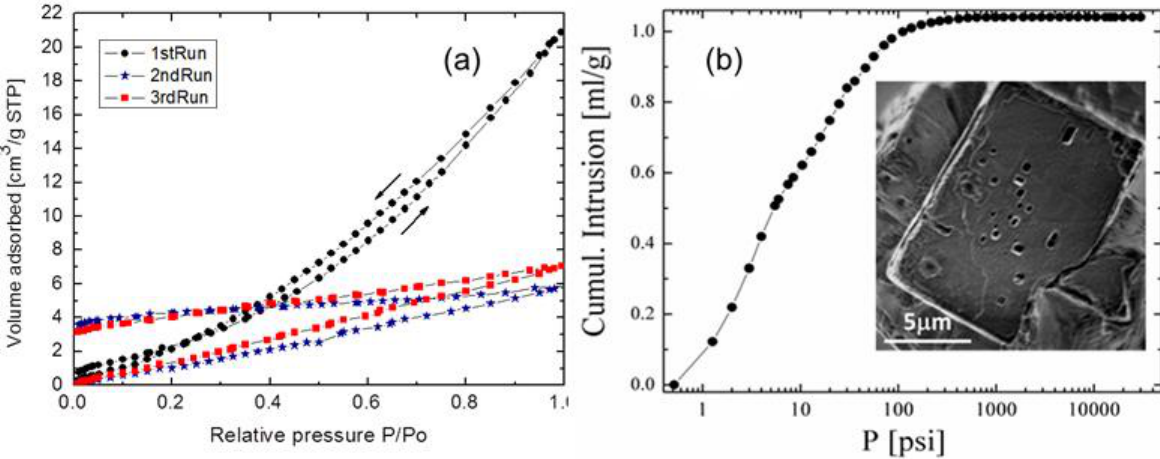
Figure 8. ( a ) Adsorption and desorption isotherms for 4 at 77 K of H temperature. ( b ) Intrusion curve as observed by Hg porosimetry; inset shows SEM micrograph of single crystal of 4 showing square shaped pores on the surface [53]. Adapted with permission from [53]. Copyright 2010 American Chemical